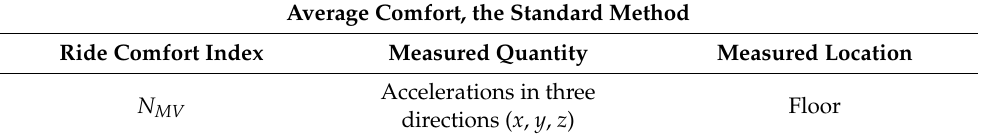
Table 1. Measured quantities and locations for evaluating the ride comfort of passengers by means of the index N MV [42].